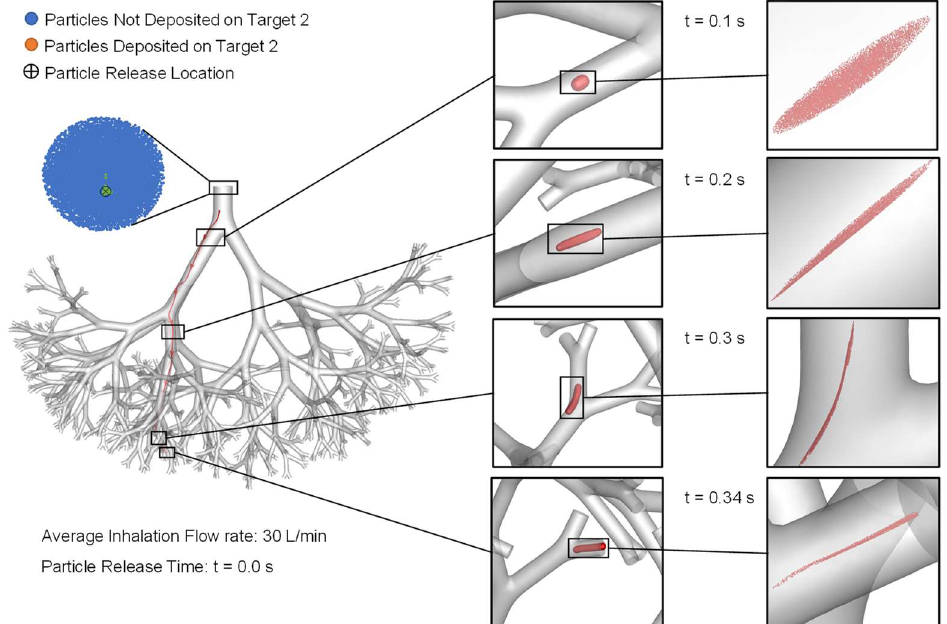
Figure 7. Particle transport dynamics for the targeted delivery simulations using the controlled particle injection method with a 0.1 mm endotracheal catheter to aim Target 2.